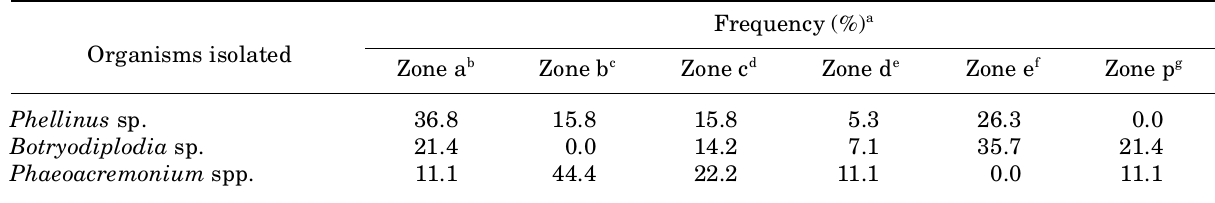
Table 1. Frequency distribution of the organisms isolated from different zones of decayed wood. Organisms isolated Phellinus sp. Botryodiplodia sp. Phaeoacremonium spp. a Percent values were calculated over the total number of isolates of each fungus. b Soft white decay. c Black line bordering the decay. d Brownish zone of hard consistency. e Sectorial brown zone of hard consistency. f Margin of sectorial brown zone. g Black spots.